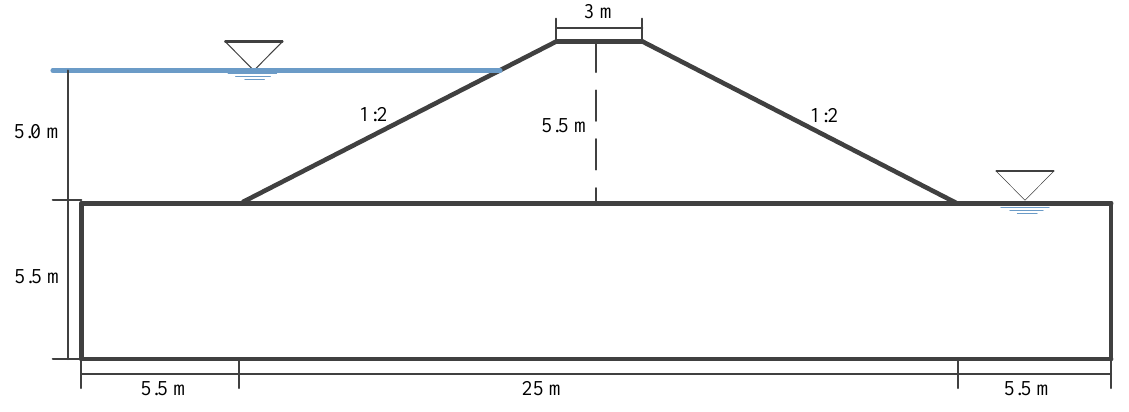
Figure 6. Plane computational model of a test embankment.